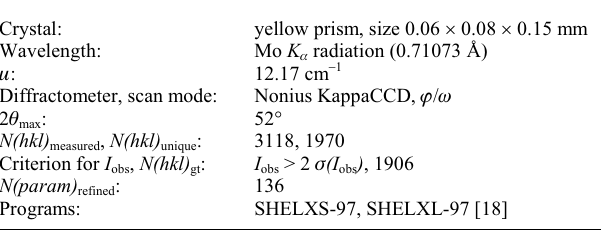
Table 1. Data collection and handling.